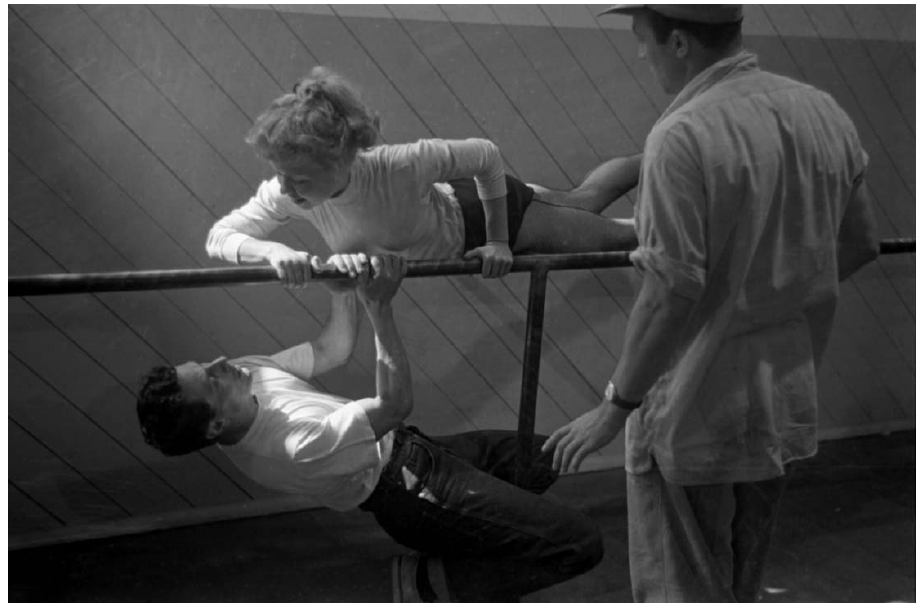
Figure 2. Gene Kelly observes Alex Romero and Vera ‐ Ellen rehearsing “A Day in New York.” Jon Brenneis photograph archive, BANC PIC 2002.171, The Bancroft Library, University of California, Berkeley. Brenneis took the photograph while employed by LIFE Magazine in July 1949. [Jon Brenneis]/[The LIFE Images Collection] via Getty Images.